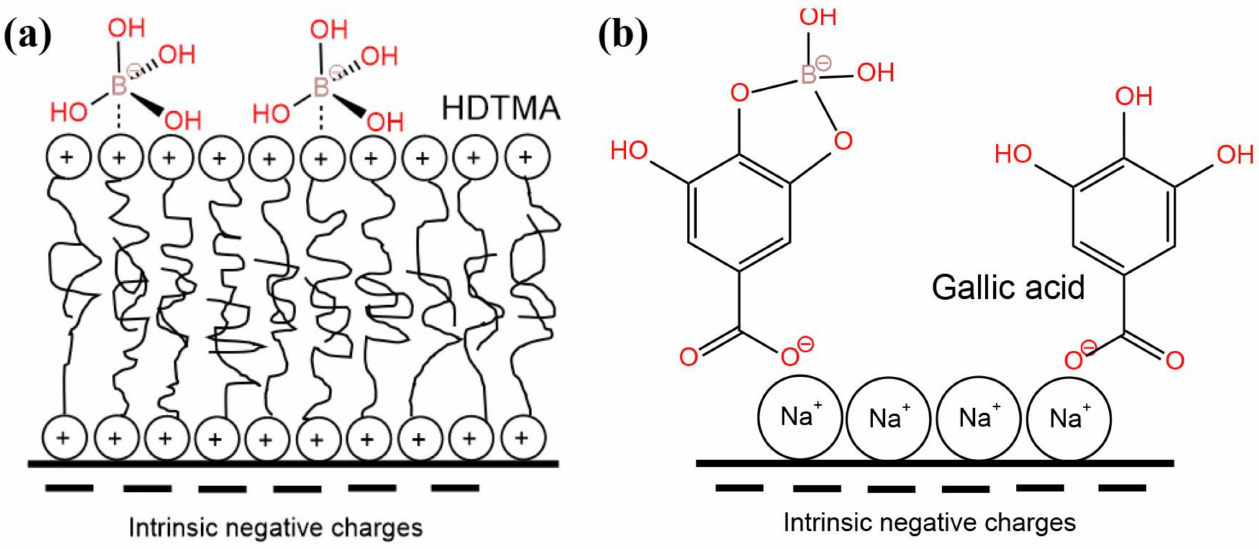
Figure 9. Scheme of the boron adsorption on vermiculate in the presence of ( a ) hexadecyltrimethy- lammonium bromide (HDTMA) and ( b ) gallic acid. Reproduced based on [80].